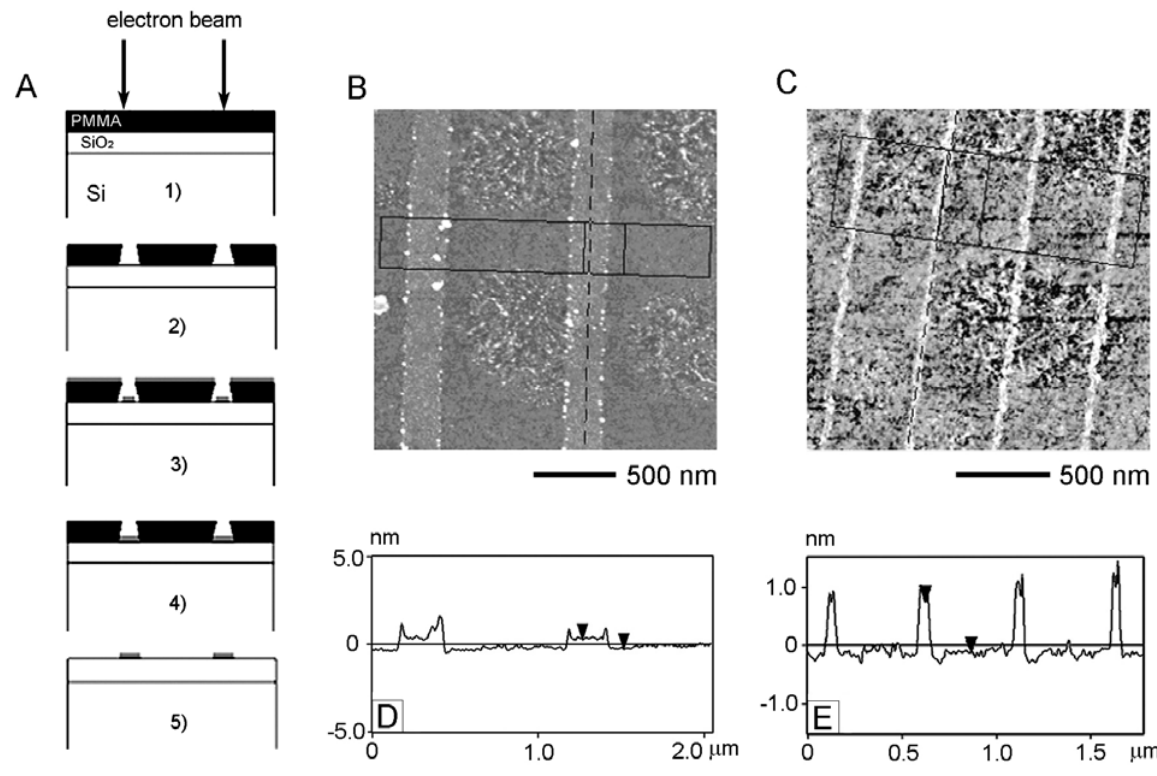
Figure 11. (A) Schematic illustration of the processes for nanopatterning of the Creutz- Taube ions on SiO substrate. (B, C) Tapping mode AFM images and (D,E) the 2 corresponding line-section analysis of two 200 nm and 35 nm lines of the nanopatterened Creutz-Taube ions on SiO 2